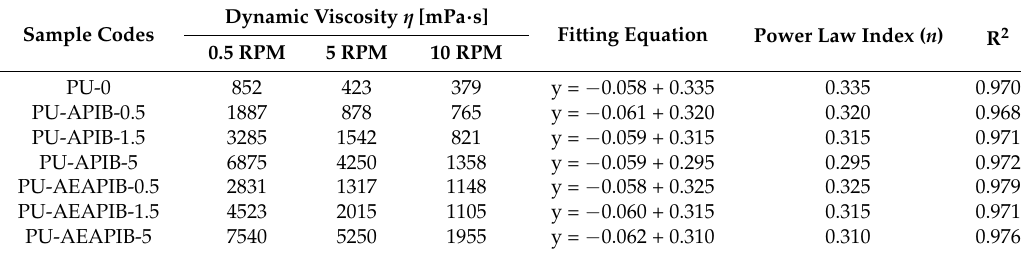
Table 1. Dynamic viscosity and logarithmic plot of the fitting equations for polyol premixes. Sample Codes